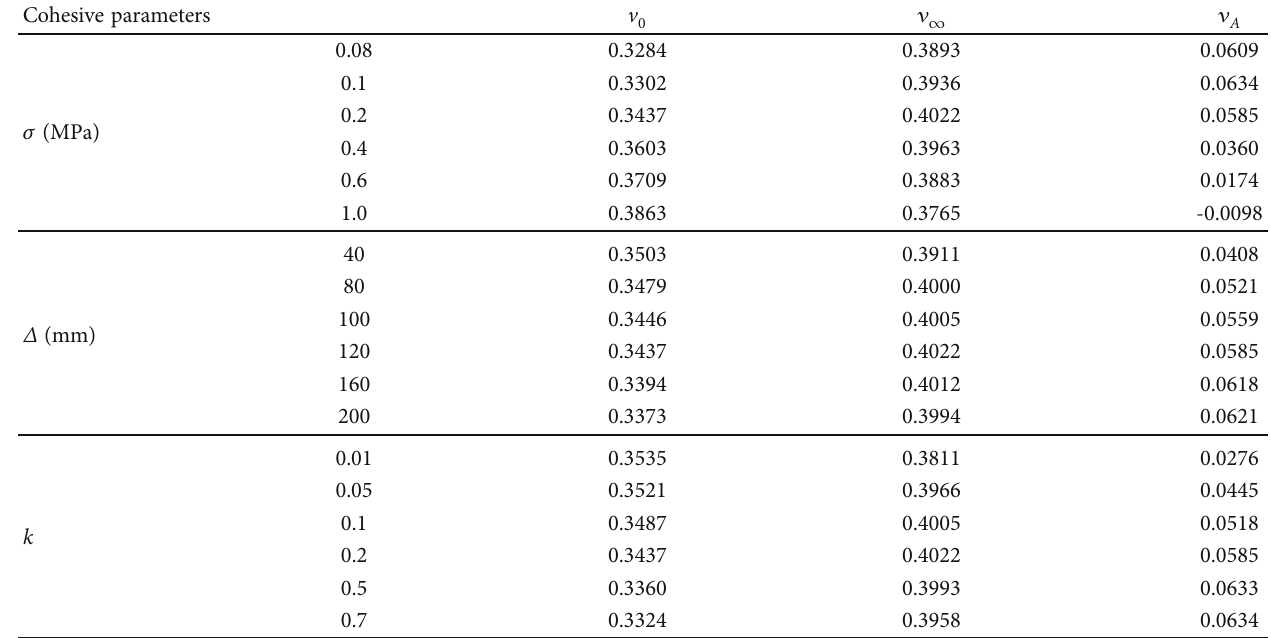
Table 4: Characteristic parameters of Poisson ’ s ratio under di ff erent cohesive